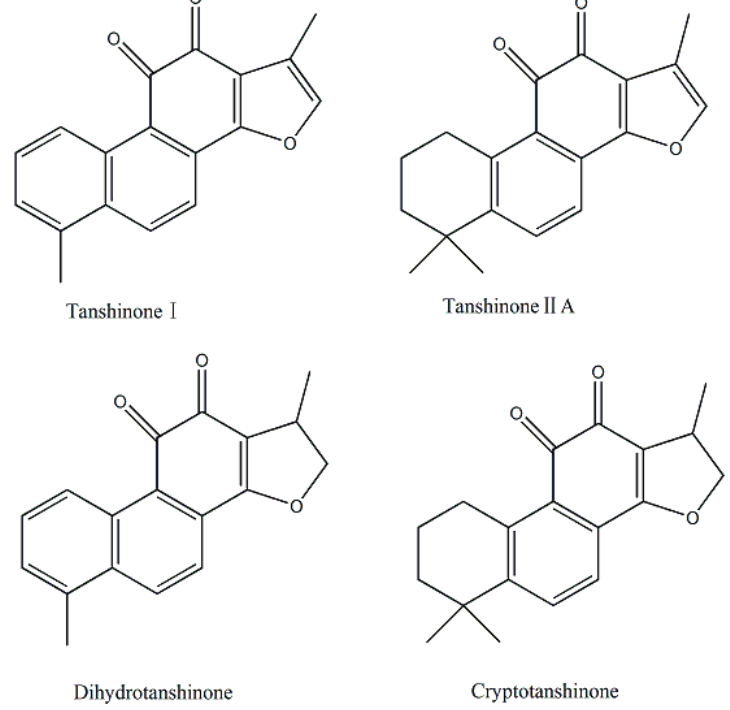
Figure 1. Chemical structures of tanshinone I, tanshinone IIA, dihydrotanshinone and